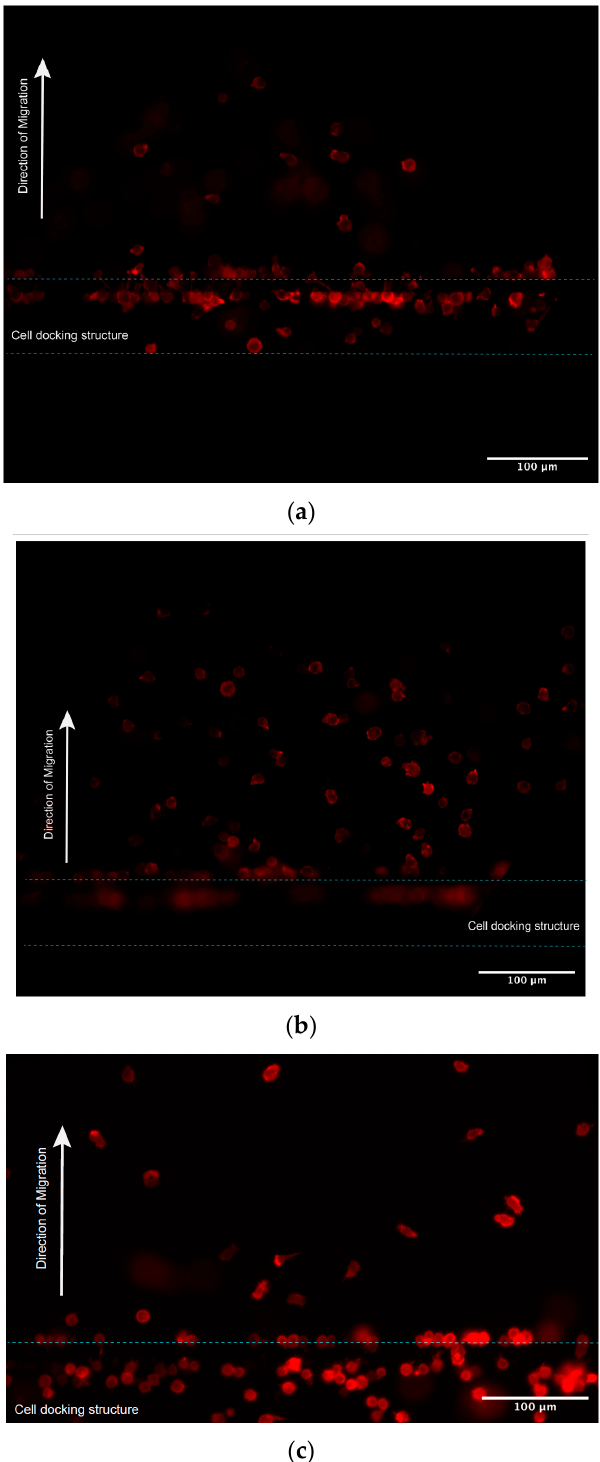
Figure 4. Cells were stained by phalloidin to observe actin filament expansion. ( a , b ) Jurkat cells were fixed at the end of 5 h chemotaxis migration experiments, followed by F-actin staining with Phalloidin- iFluor 594 reagents working solution. ( a , b ) Representive different cells locations under different focal planes. ( c ) Primary T cells were fixed at the end of 0.5 h chemotaxis migration experiments, followed by F-actin staining with Phalloidin-iFluor 594 reagents working